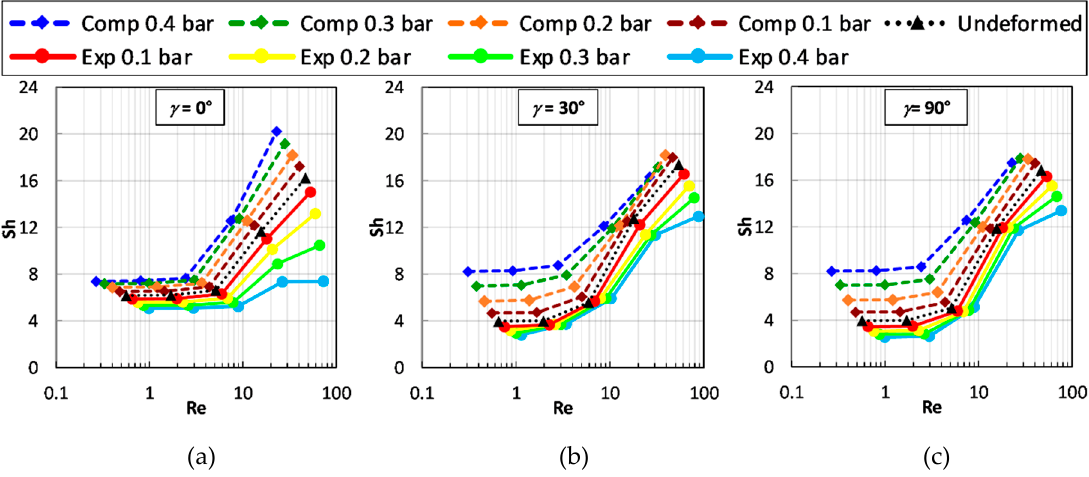
Figure 10. Sherwood numbers on either of the walls as a function of the Reynolds number for P / H = 10 at different transmembrane pressures and flow attack angles. ( a ) γ = 0°; ( b ) γ = 30°; ( c ) γ = 90°.